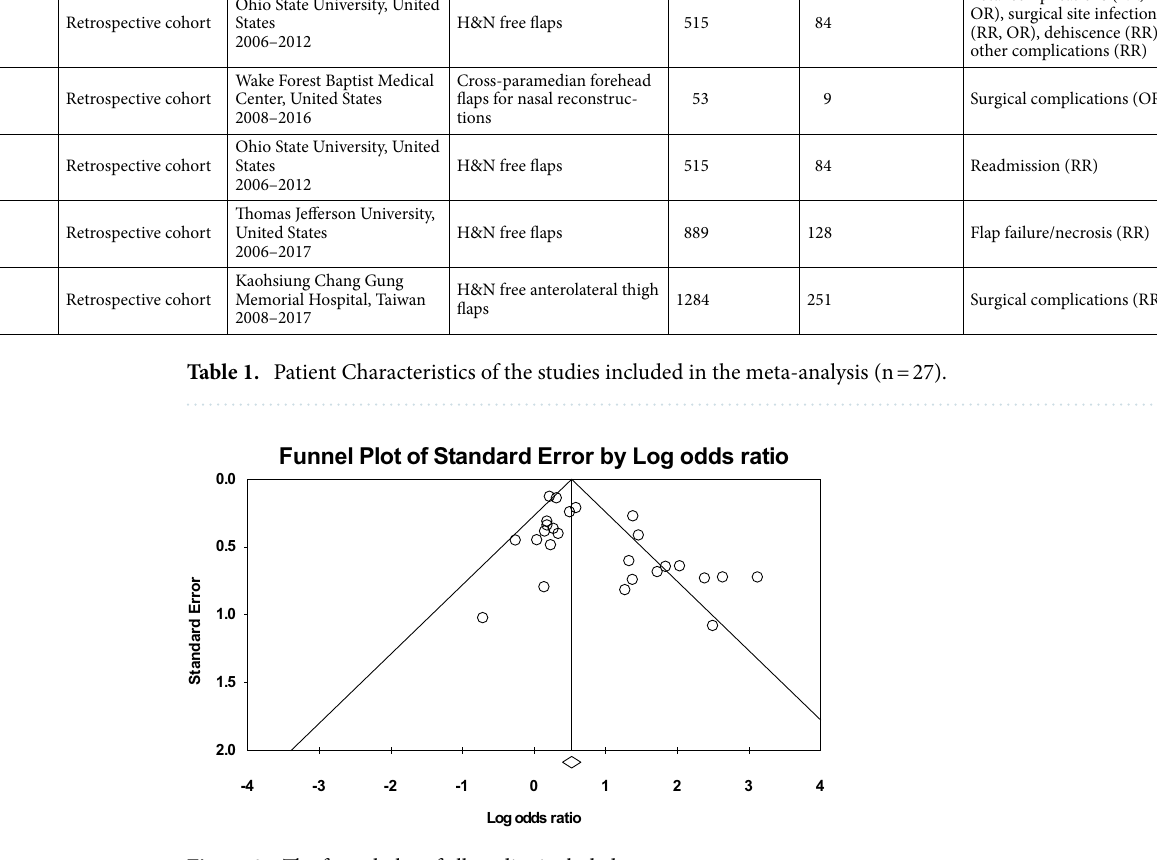
Figure 2. The funnel plot of all studies